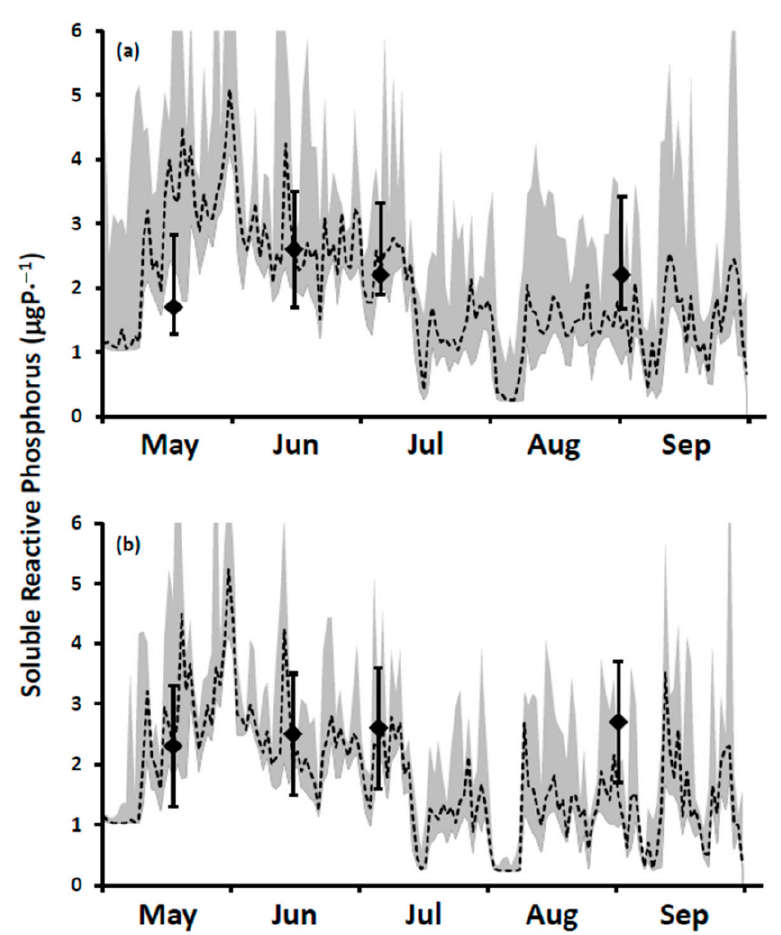
Figure 8. Results of model performance testing for soluble reactive phosphorus concentrations in 2016: ( a ) surface water and ( b ) bottom water. Diamonds represent observed median concentrations with the 25th and 75th percentiles indicated by bars. Dashed line represents daily median modeled concentrations with the 25th and 75th percentiles for each daily median shaded in